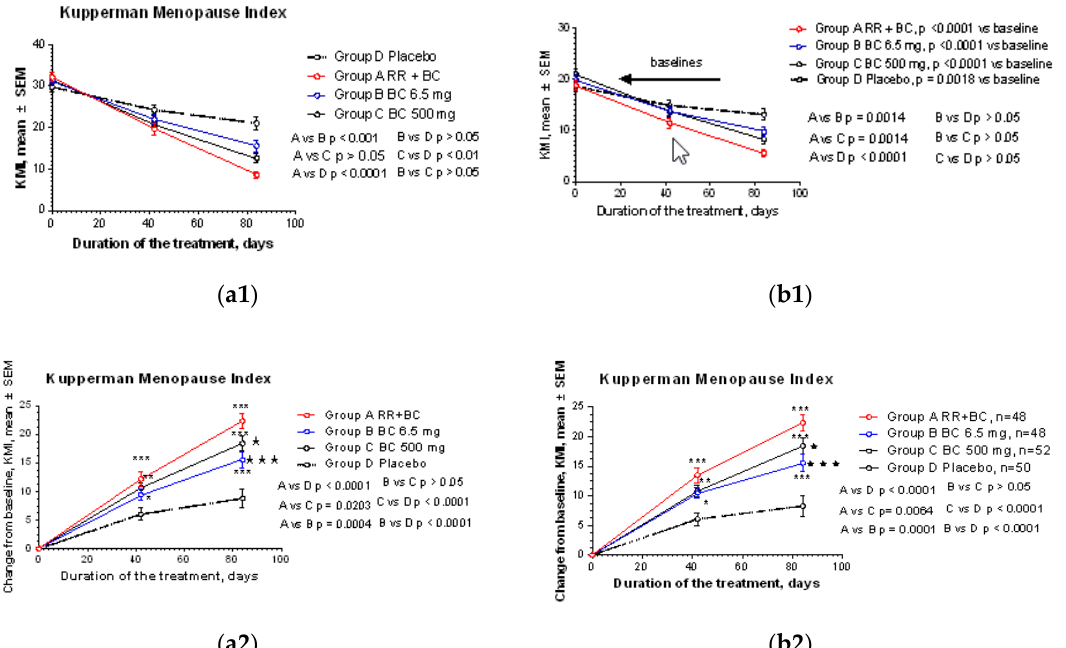
Figure A1. KMI ( a1 ) -ITT analysis, ( b1 ) -PP analysis. The change from baseline of KMI (mean ± SD) over time: ( a2 ) -ITT analysis, ( b2 ) -PP analysis. Significance of difference between groups at various time points, calculated by Bonferroni post-test, is expressed by symbols * p < 0.05, ** p < 0.01, *** p < 0.001; ns: not significant (A, B, C vs. placebo) and * p < 0.05 (C vs. A), *** p < 0.001 (B vs. A).